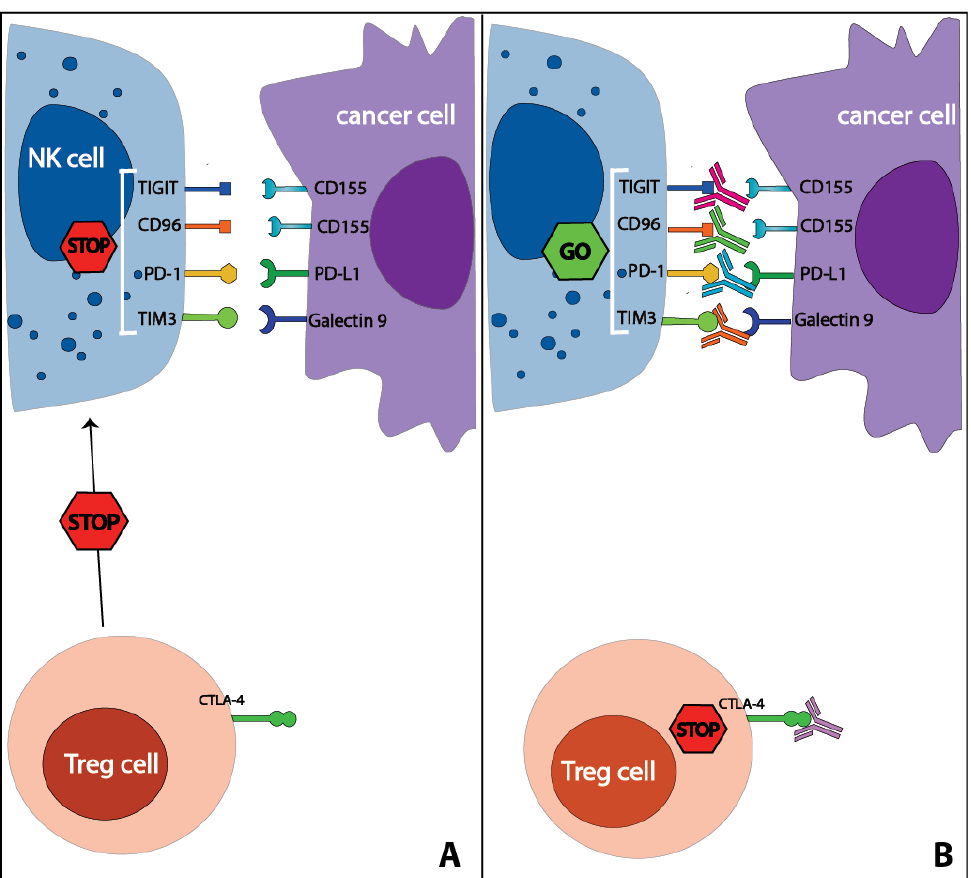
Figure 3. Effects of immune checkpoint inhibitor therapies on NK cells. NK cells can express various immune checkpoints such as PD-1, TIM3, TIGIT, CD96, which, upon binding to their ligands, impair NK cell function ( A ). Antibodies targeting these immune checkpoints were shown to restore NK cell activity ( B ). CTLA-4 is not expressed by human NK cells; however, anti-CTLA-4 therapy positively affects NK cell activity by reducing Treg-mediated suppression. A selection of immune checkpoint ligands is shown in the figure. TIGIT: T cell immunoglobulin and immunoreceptor tyrosine-based inhibitory motif domain; PD-(L)1: programmed cell death protein (ligand) 1; TIM3: T-cell immunoglobulin- and mucin-domain-containing molecule-3; CTLA-4: cytotoxic T-lymphocyte-associated protein 4.